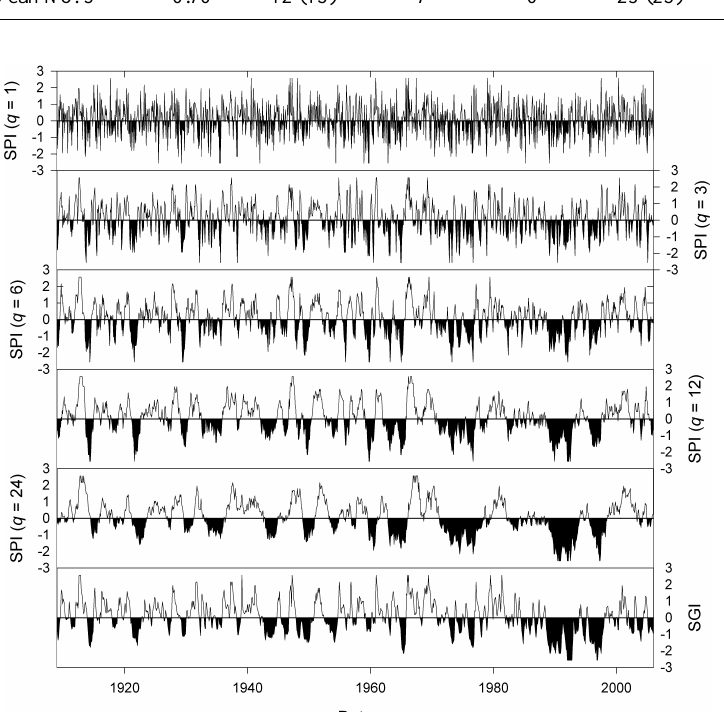
Fig. 6. SPI for Dalton Holme for accumulation periods q =1, 3, 6, 12 and 24 (top five panels) and corresponding SGI (bottom panel). Episodes of drought are shown in black and are denoted by negative values of SGI and